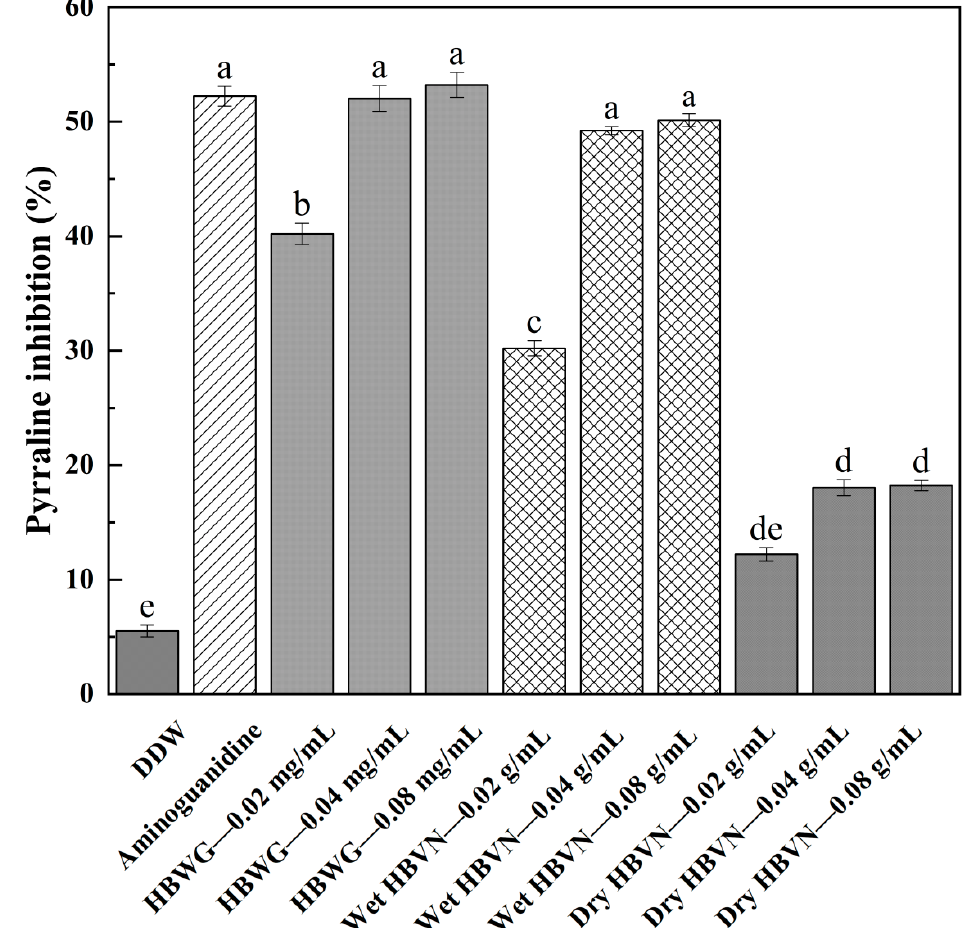
Figure 3. Inhibitory effect of HBWG and fresh and dry HBVN on pyrraline formation. Marker. Error bars are standard deviations ( n = 3). Different letters above the columns represent significant difference at p < 0.05.